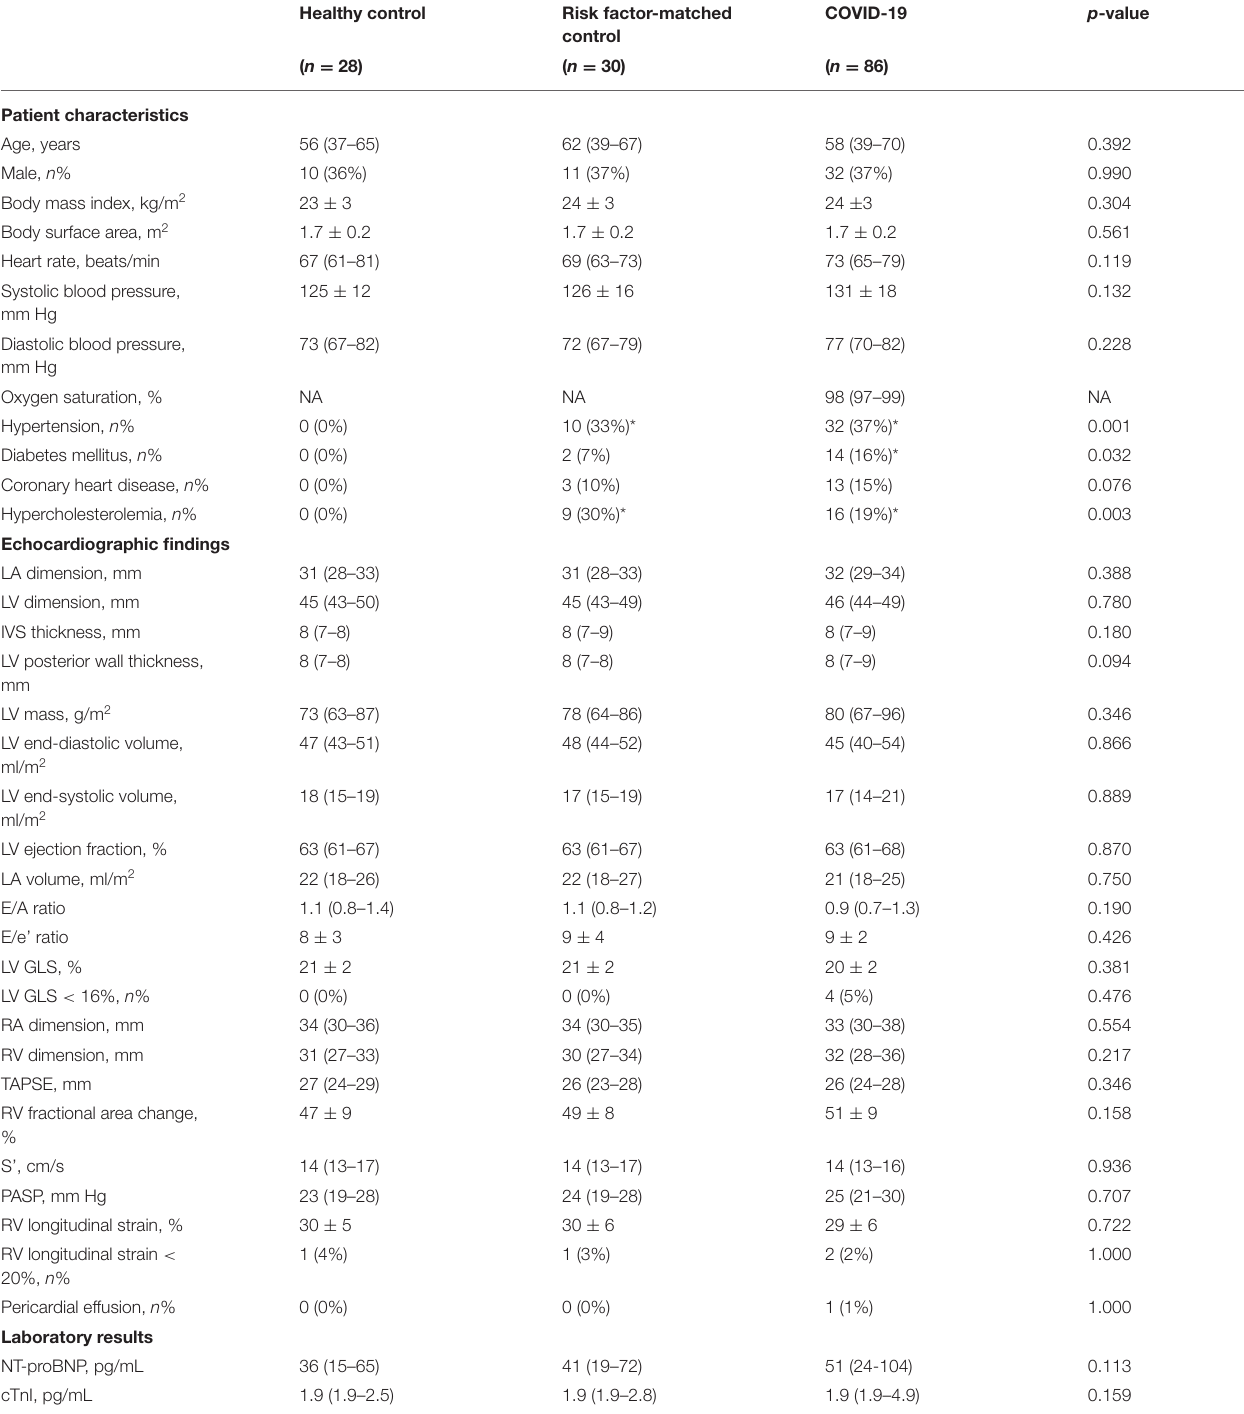
TABLE 1 | Clinical characteristics, echocardiographic findings, and laboratory results of coronavirus disease 2019 (COVID-19) survivors 327 days after diagnosis. Healthy